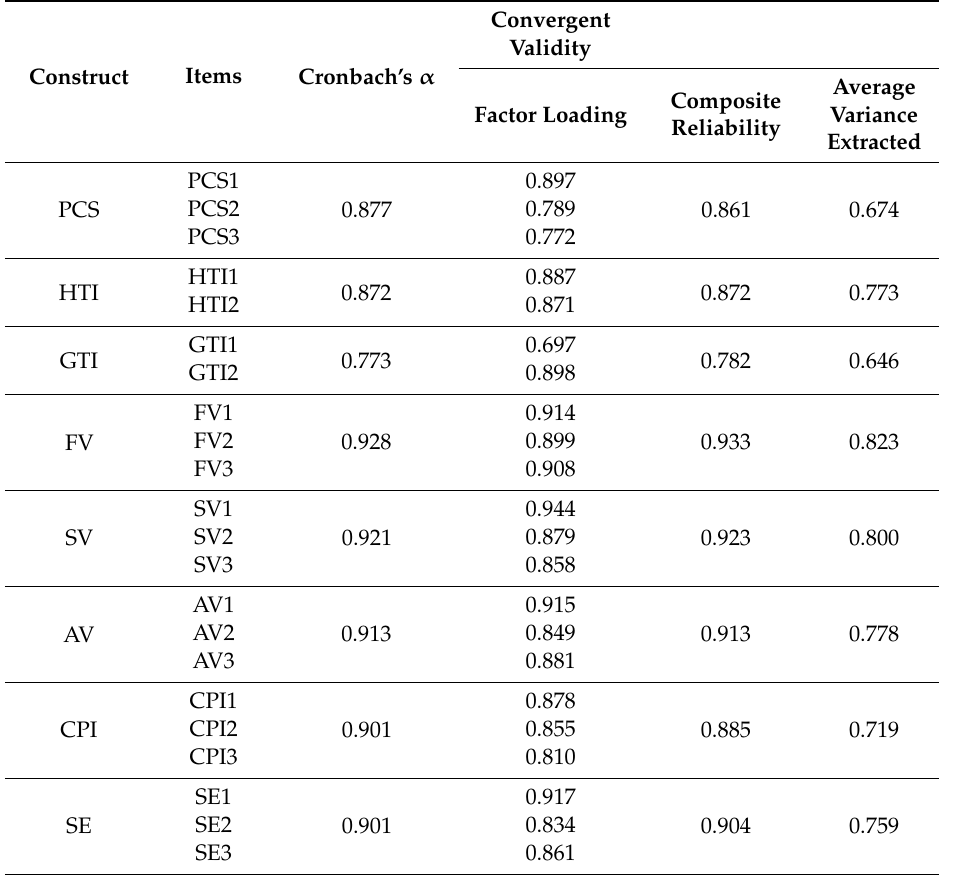
Table 4. Test results of internal reliability and convergent validity.